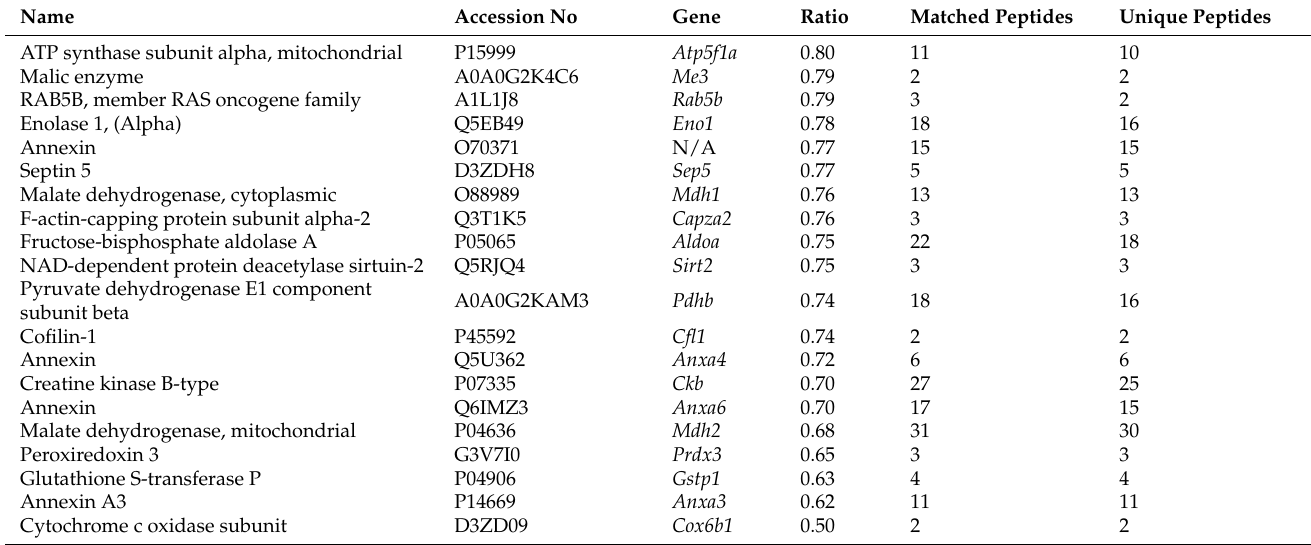
Table 1. Synaptosomal differentially downregulated expressed proteins in Controls + Fluoxetine vs. Controls.